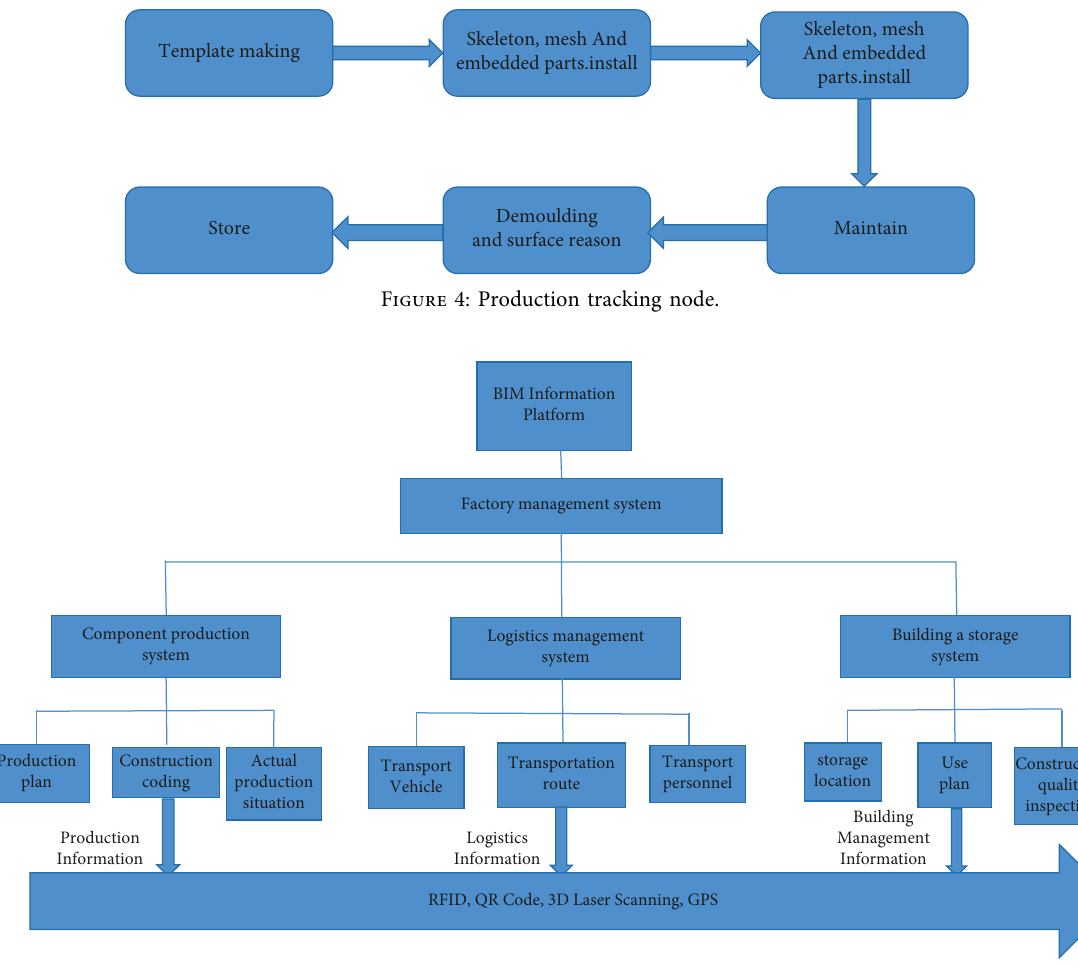
Figure 5: Production tracking of prefabricated